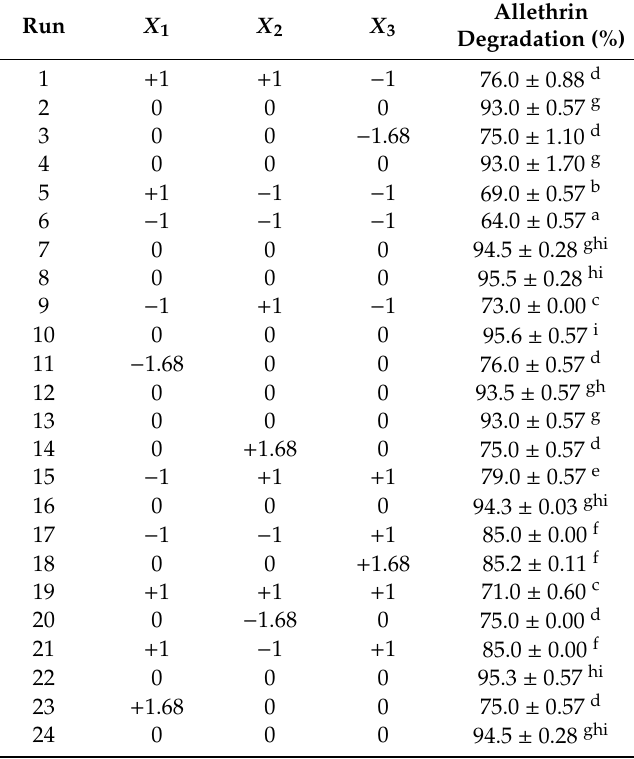
Table 1. Central composite design (CCD) for the optimization of allethrin degradation using strain